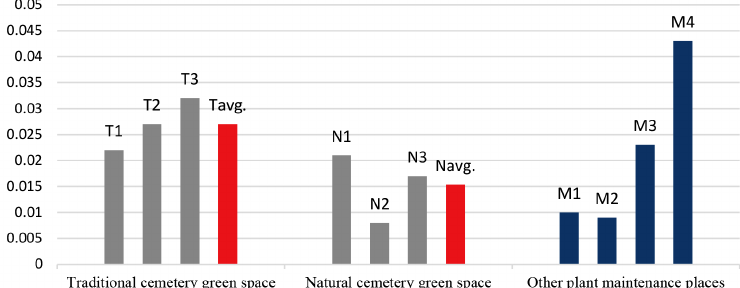
Figure 10. Comparison of the GWP indexes of cemetery green space and the various types of plant site